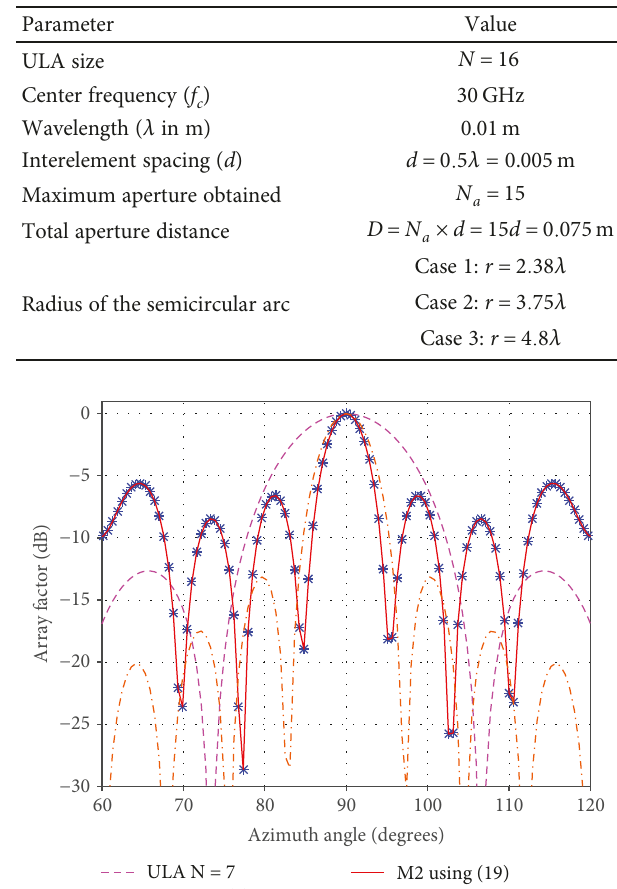
Table 1: Simulation Parameters.